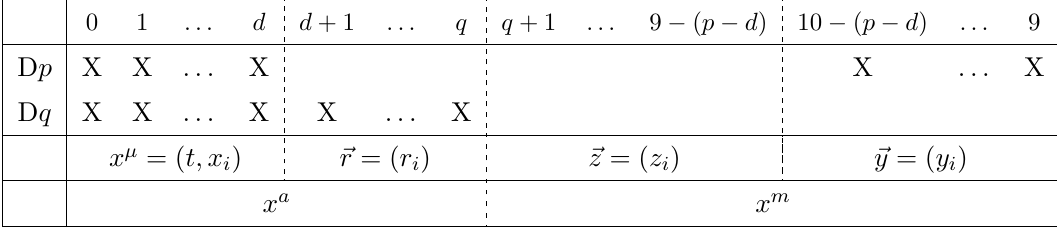
Table 1 . D p /D q